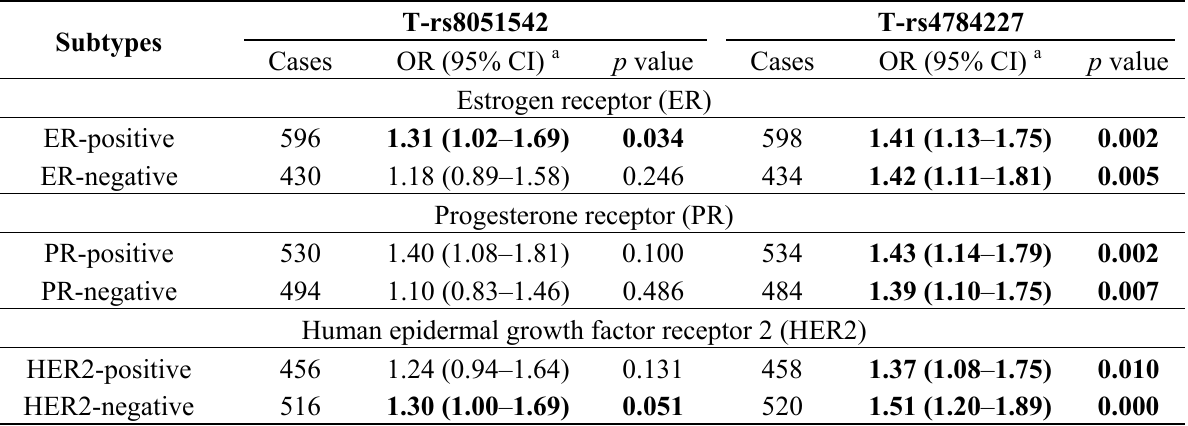
Table 3. Association of T-rs8051542 and T-rs4784227 with breast cancer subtypes in additive model.